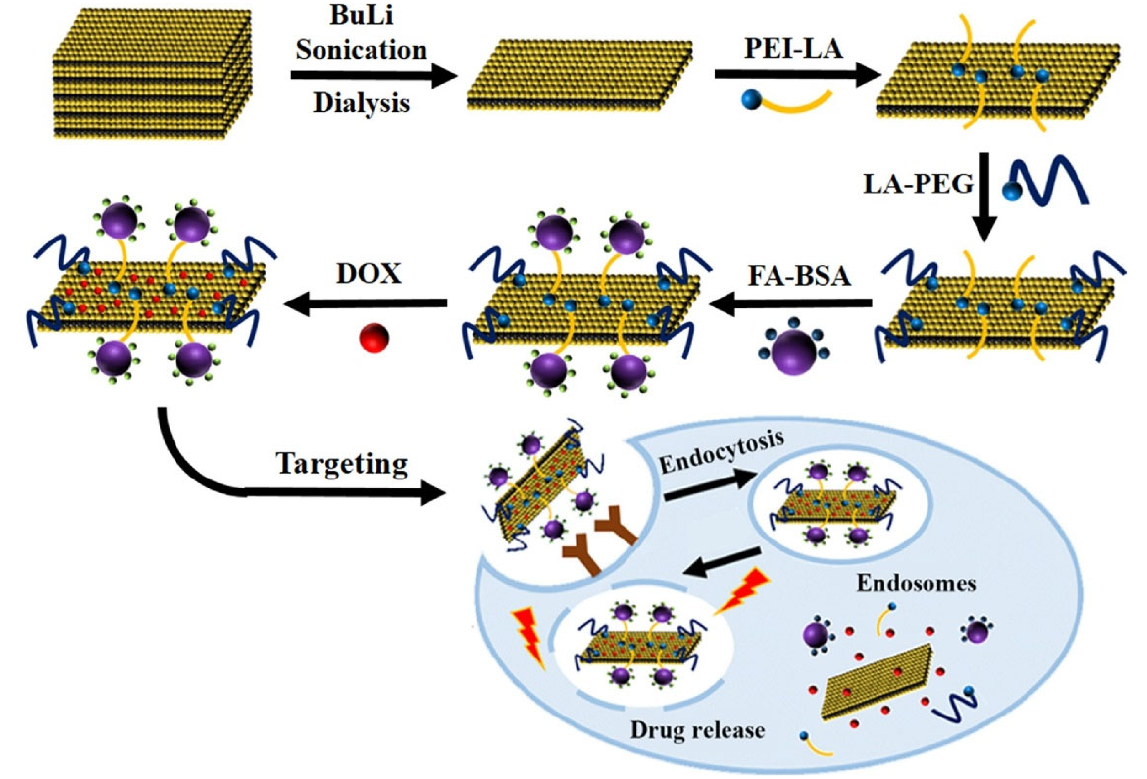
Figure 4. Schematic illustration depicting the construction of MoS 2 ‐ based nanoplatform for the enriched loading and targeted release of DOX [38].